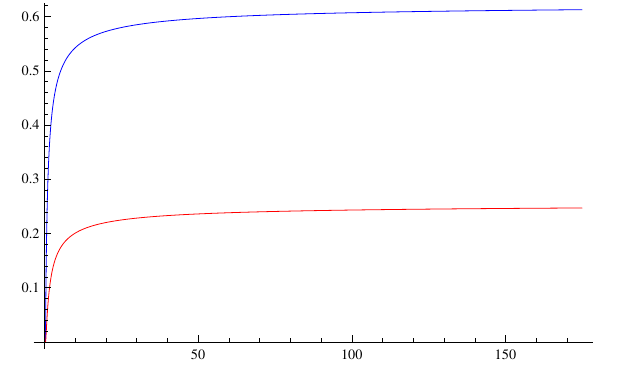
Figure 4 . The ratio _ S (cid:3) = 2 M is plotted as a function of the black hole mass. We have set g = 1 ; (cid:11) = 3 ; ! 2 = 4 (cid:25) ; G = 1 = 4.